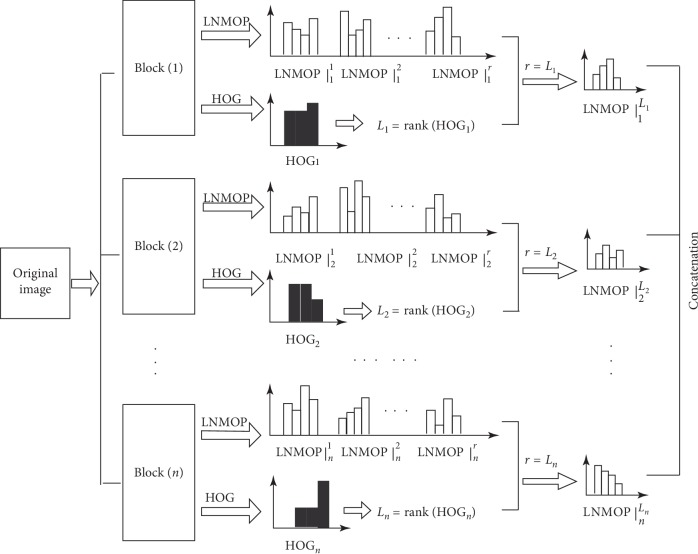
The flowchart of Algorithm 2.